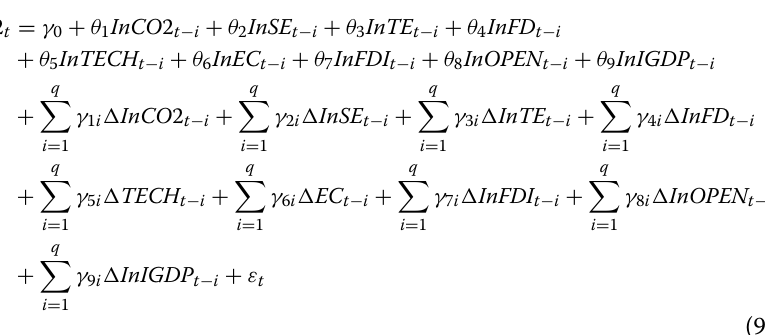
N/A not available, WDI World Development